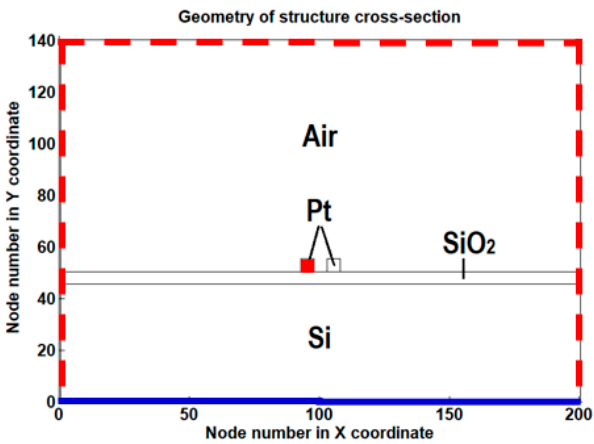
Figure 1. Cross-sectional area of the microelectromechanical system (MEMS) test structure where the Dirichlet boundary conditions are marked with a blue line, the Neumann boundary conditions are marked with a red dashed line, and the internal heat source is marked using red color.